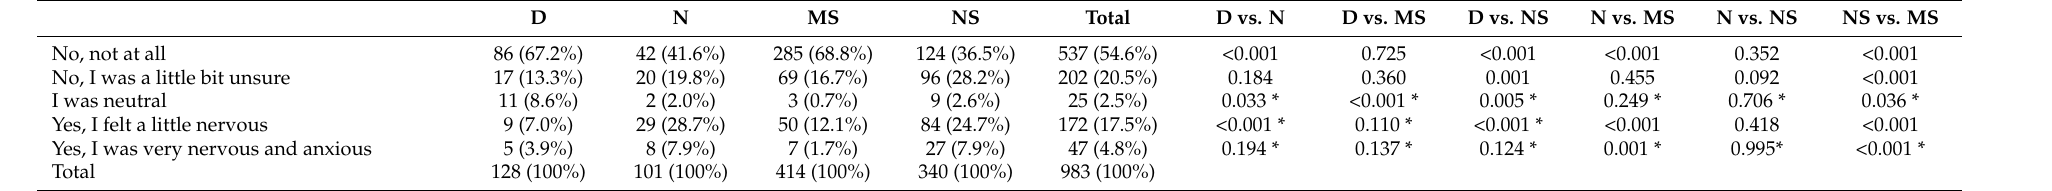
Table 3. Stress, fear, or any objections prior to vaccination against COVID-19 in four groups of vaccinated healthcare workers.